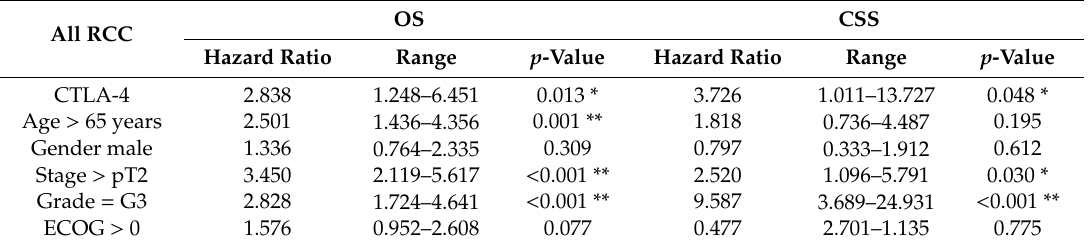
Table 6. Multivariate Cox regression analysis: Association of clinical parameters and CTLA-4 expression with OS or CSS in all RCC patients.